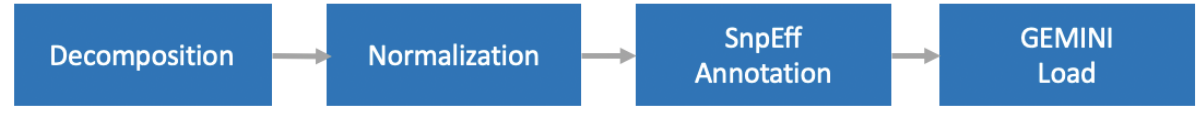
Figure 3. GEMINI pipeline schema. SnpEff: single nucleotide polymorphism effect; GEMINI: GEnome